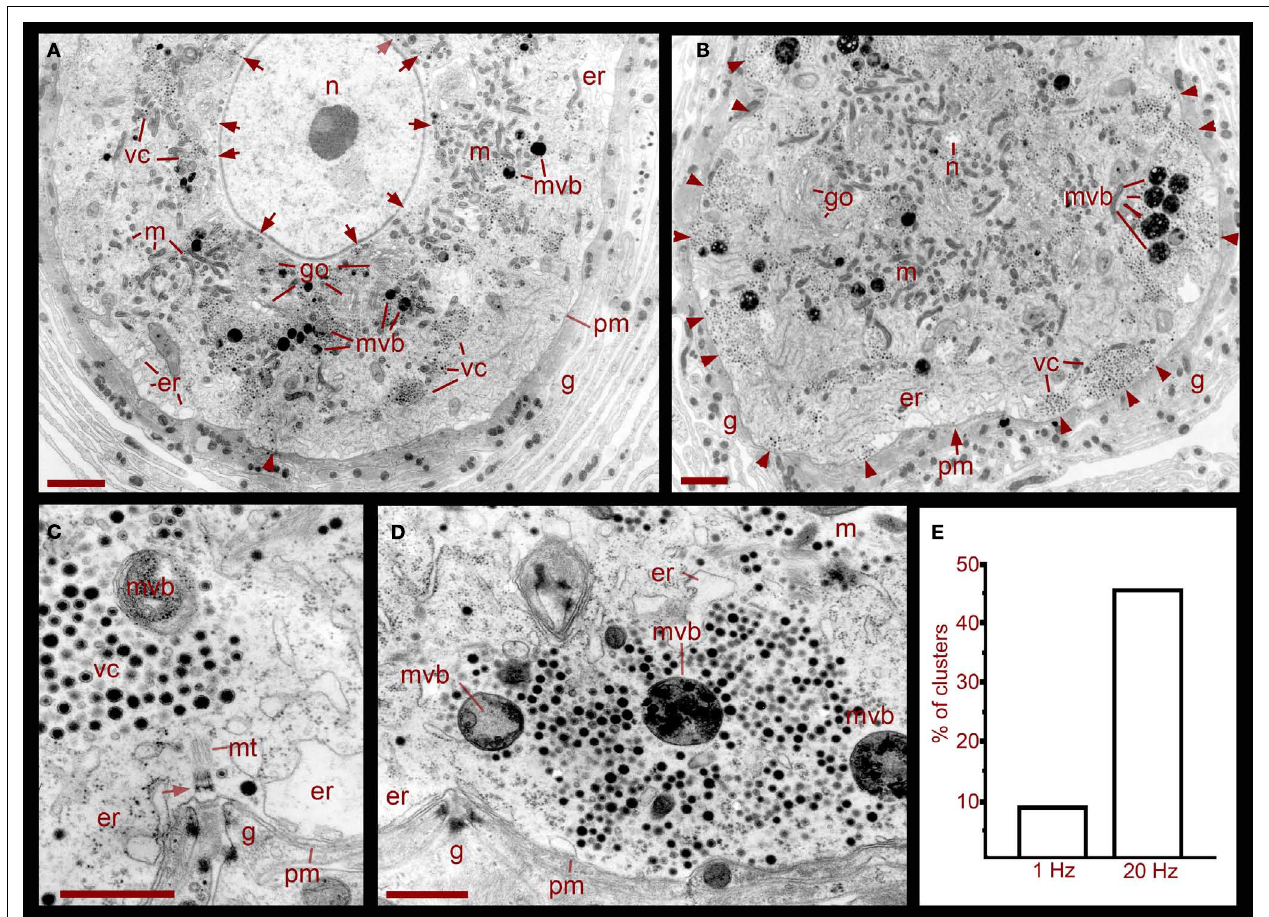
near the nucleus (n). Scale = 2 μ m. (C) Magnified electron micrograph of a peripherally located vesicle cluster in a neuron that had been stimulated at 1Hz.Vesicle clusters are located away from the plasma membrane and the intermediate space contains endoplasmic reticulum. A bundle of